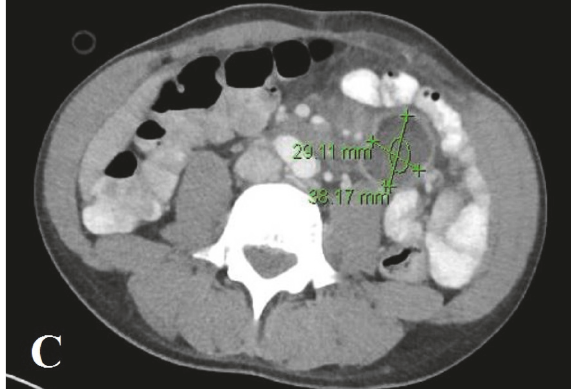
Figure 3: Two rim-enhancing hypodense lesions within the central mesentery of the